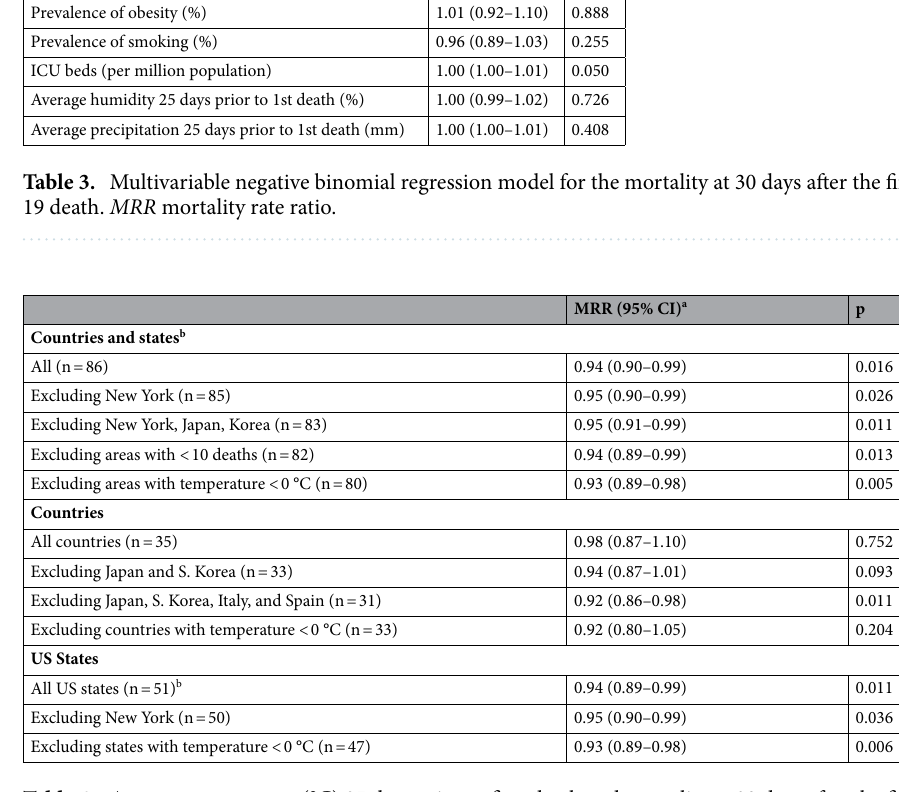
Table 4. Average temperature (°C) 25 days prior to first death and mortality at 30 days after the first death. MRR mortality rate ratio. a Adjusting for average PM2.5 25 days prior to 1st death, days of social distancing before 1st death, density of largest city, Gini index, proportion older than 75 years, prevalence of obesity, prevalence of smoking, ICU beds, average humidity 25 days prior to 1st death, average precipitation 25 days prior to 1st death. b Includes District of